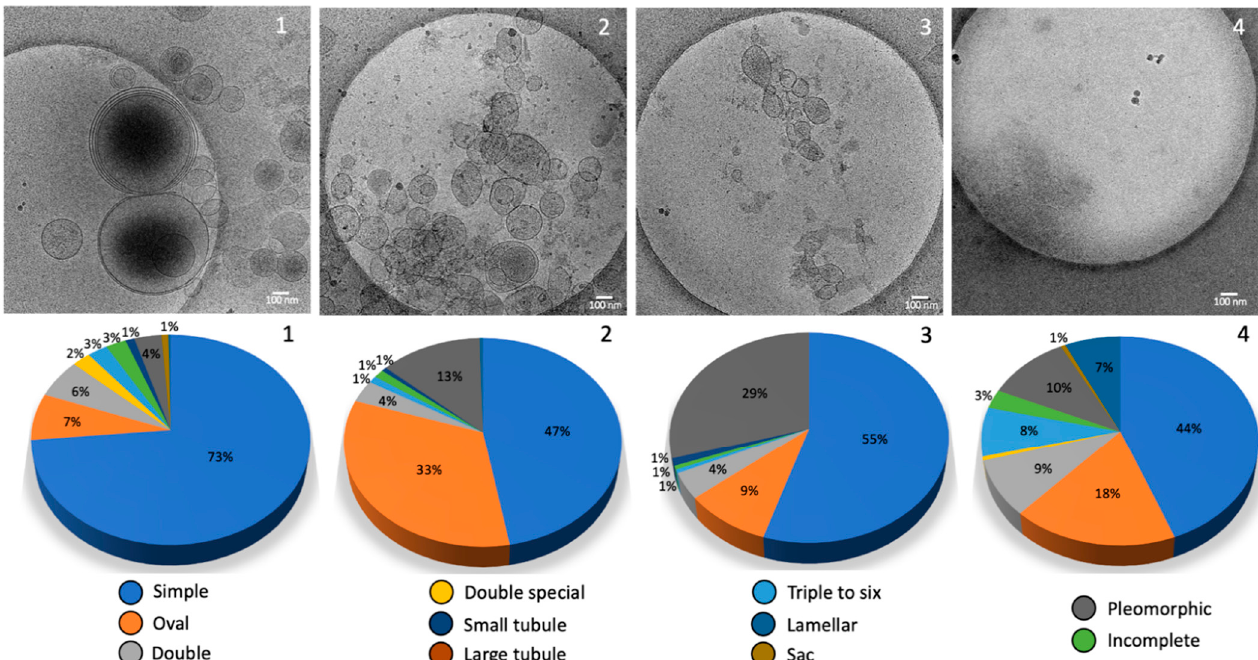
Figure 7. Morphology of the different conditions analyzed using Cryo-TEM: images used for morphological quantification pie histogram and corresponding pie histograms and vesicle percentages according to the morphological classification in Figure 4.